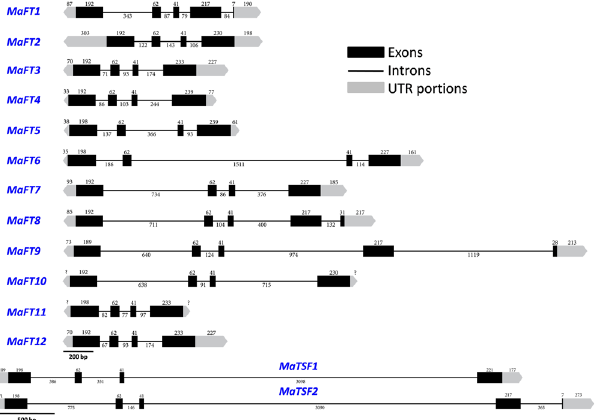
Figure 1. Schematic representation of the genomic organization of FT / TSF -like genes of banana. The black boxes represent different exons while the lines represent introns. The 5 ′ and 3 ′ UTRs are shown as grey pentagons. Numbers represent the lengths (bp) of exons, introns (shown below the lines) and UTRs (shown above the